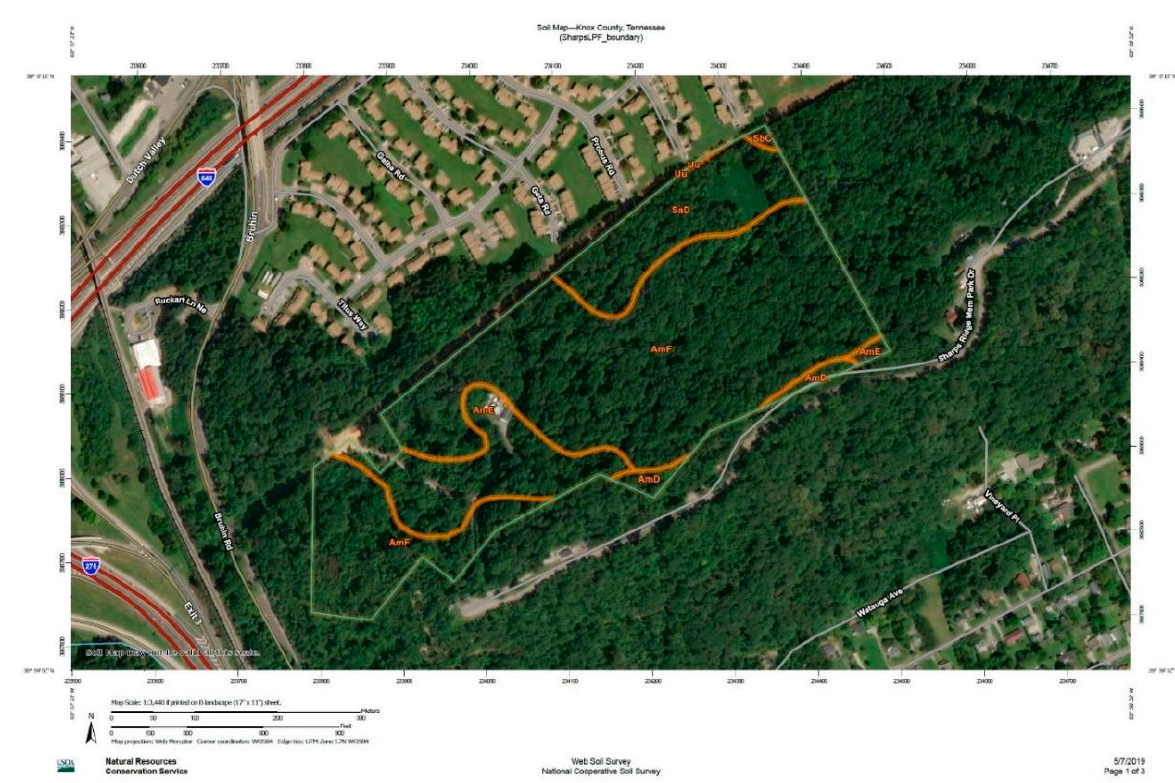
Figure A1. Soil map for the 17-hectare parcel at Sharp’s Ridge (USDA Natural Resource Conservation Service Web Soil Survey, 2019). Table A1. Soil map legend for Area of Interest presented in Figure A1 (USDA Natural Resource Conservation Service Web Soil Survey, 2019).